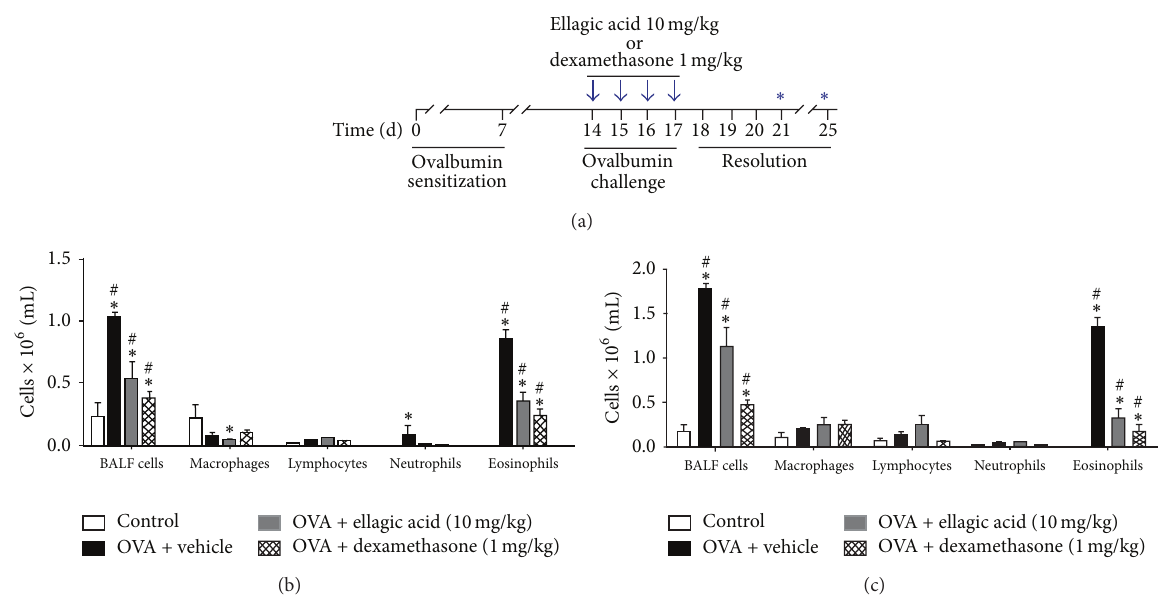
Figure 1: Ellagic acid prevents the development of airway inflammatory responses in experimental airways allergic inflammation. Mice received ellagic acid (10mg/kg, p.o.), dexamethasone (1mg/kg, s.c.), or vehicle (water, p.o.) 30 minutes prior in accordance to the preventive protocol (see Section 2) and euthanized on 21 or 25 days and cells in bronchoalveolar lavage were counted (a). BALF cells and leukocytes subset at 21 days (b); BALF cells and leukocytes subset at 25 days (c). One group of animals received vehicle (control group). Results represent the mean ± SEM, of two or more independent experiments with four mice per group per experiment. ∗ 𝑃 < 0.05 compared with control group; # 𝑃 < 0.05 compared with ovalbumin + vehicle